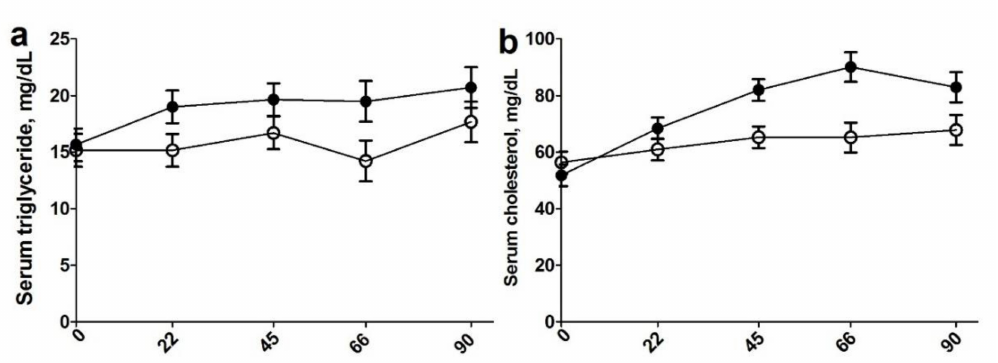
Figure 3. Plasma triglycerides ( a ) and cholesterol ( b ) concentrations on d 0, 22, 45, 66, and 90 ( y axis) of treatment for steers individually supplemented an isocaloric, isonitrogenous diet with no rumen by-pass lipid (CON; n = 24; open circle) or with a rumen by-pass lipid (Essentiom ™ ; RBL; n = 24; closed circle) daily. Values are ± SEM (Treatment: p = 0.002; Day: p = 0.03 and Treatment × Day p = 0.01, respectively). Table 3. Specific and total serum fatty acids (mg / mL) on d 0 of steers that were early weaned at 150 d of age (n = 24) or traditionally weaned at 210 d of age (n = 24) and then supplemented with a rumen by-pass lipid ration (RBL) or an isocaloric, isonitrogenous control diet (CON). Early Wean Traditional Fatty Acid